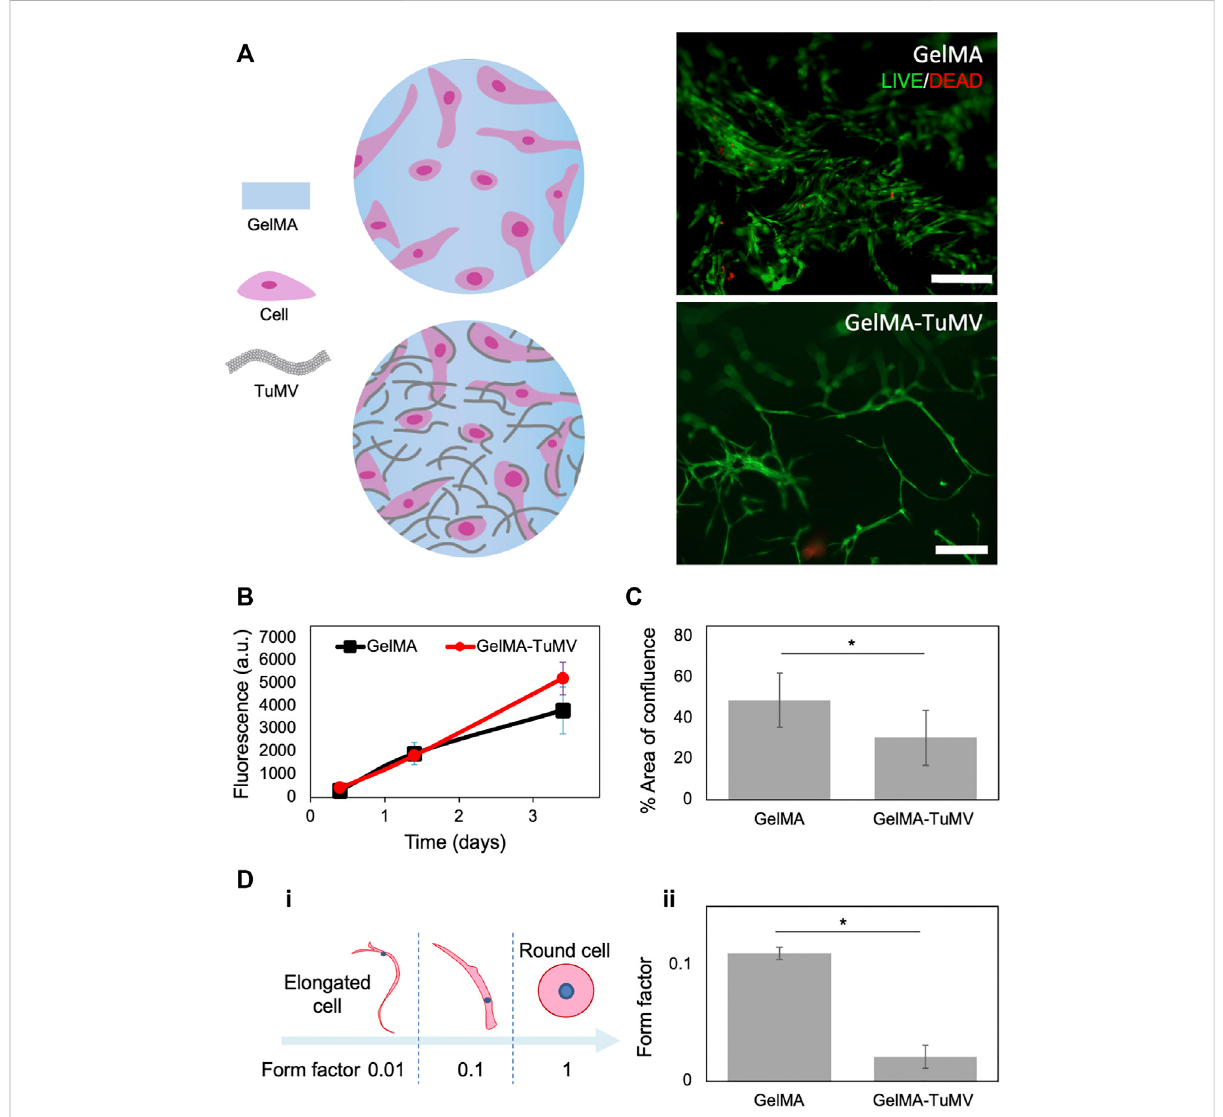
FIGURE 2 BJ fi broblasts cultured on GelMA hydrogels and on GelMA coated with TuMV. (A) LIVE/DEAD ® micrographs on day 3. Scale bar 200 μ m. (B) Metabolic activity measured by PrestoBlue ™ assay. (C) Evaluation of cell coverage area, and (D) cell morphology assessment conducted by image analysis in LIVE/DEAD ® micrograph at day